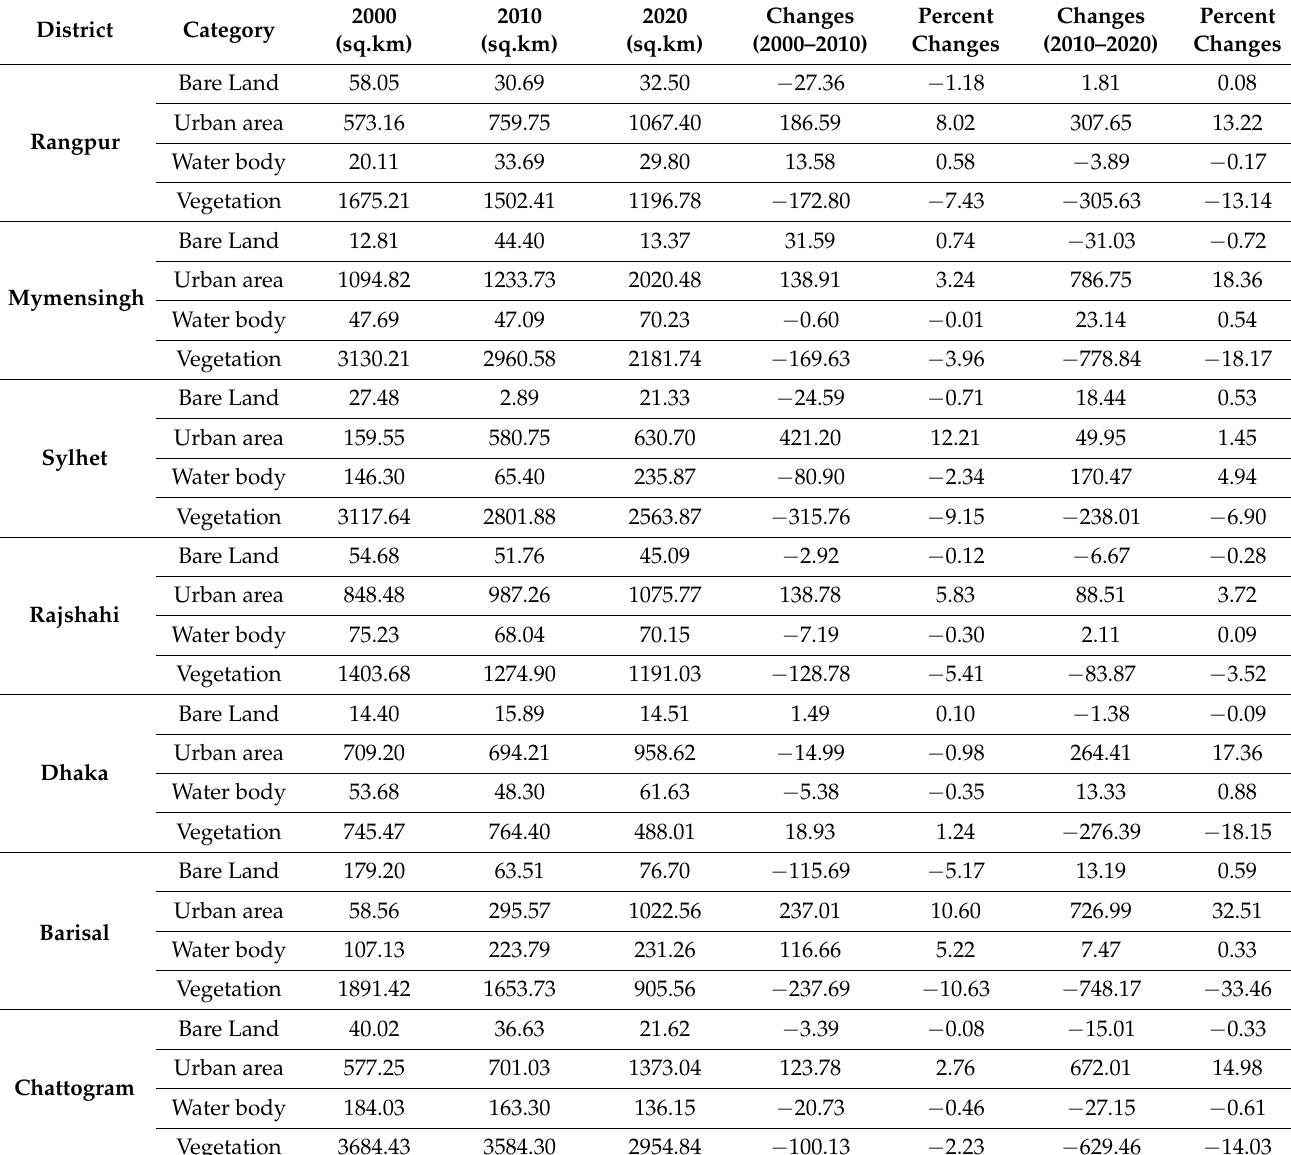
Table 3. LULC changed